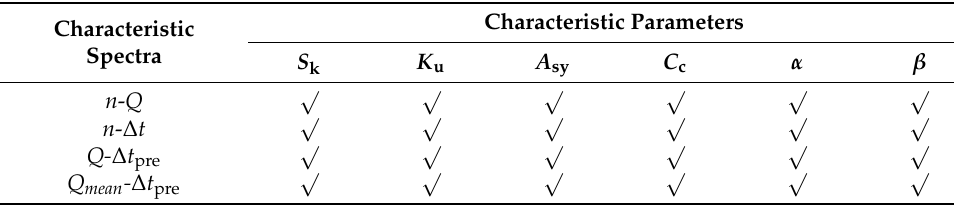
Table 1. Statistical characteristic parameters of creepage discharge.